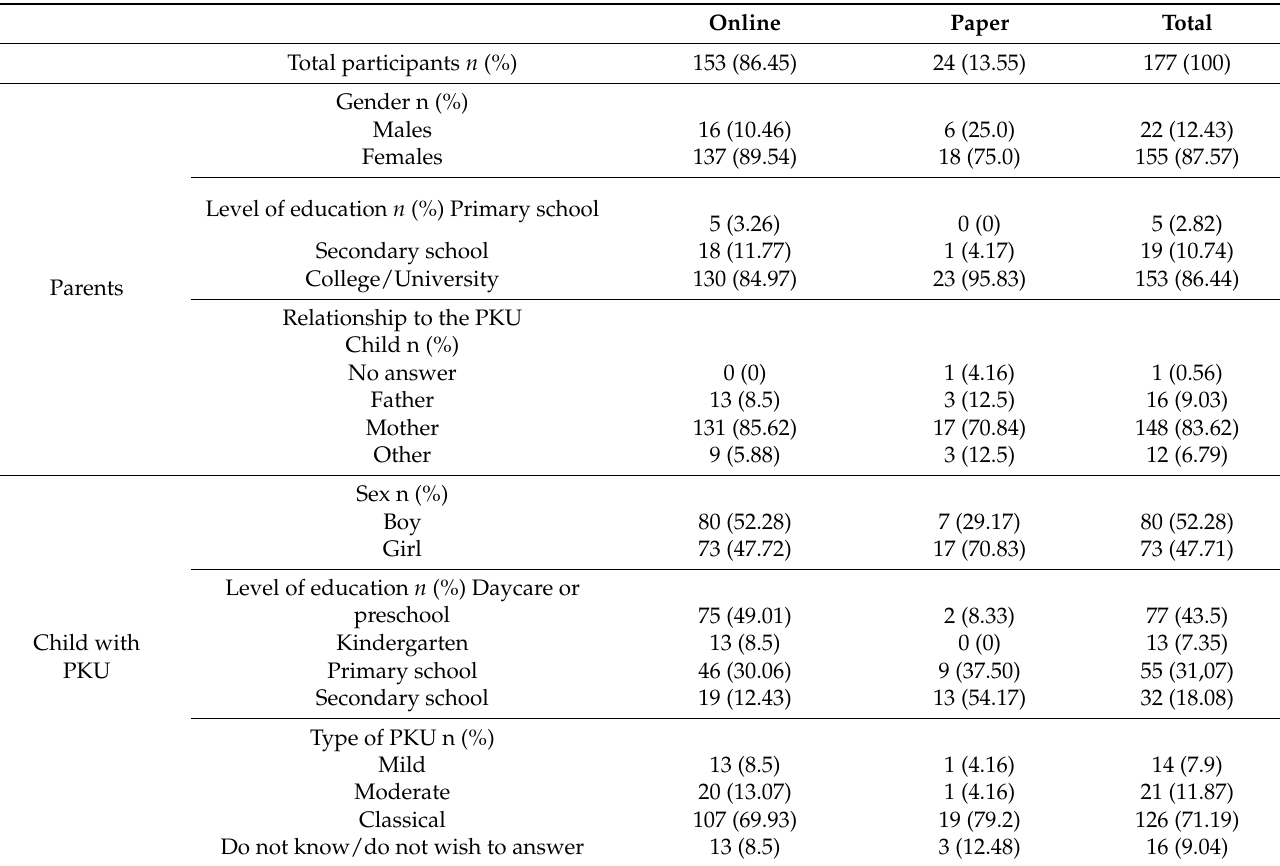
Table 1. Demographic characteristics of the participants.